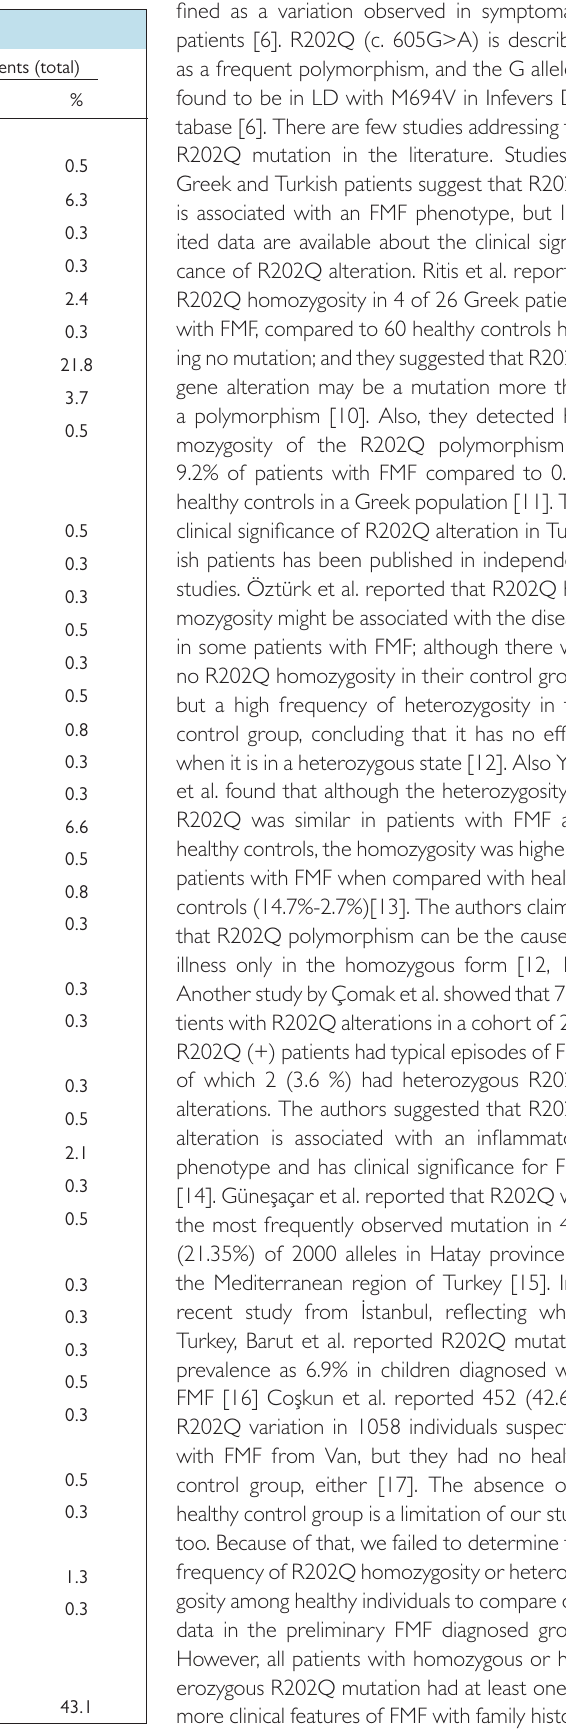
Table 1. Genotype distribution of our patients Mutation (n; %)